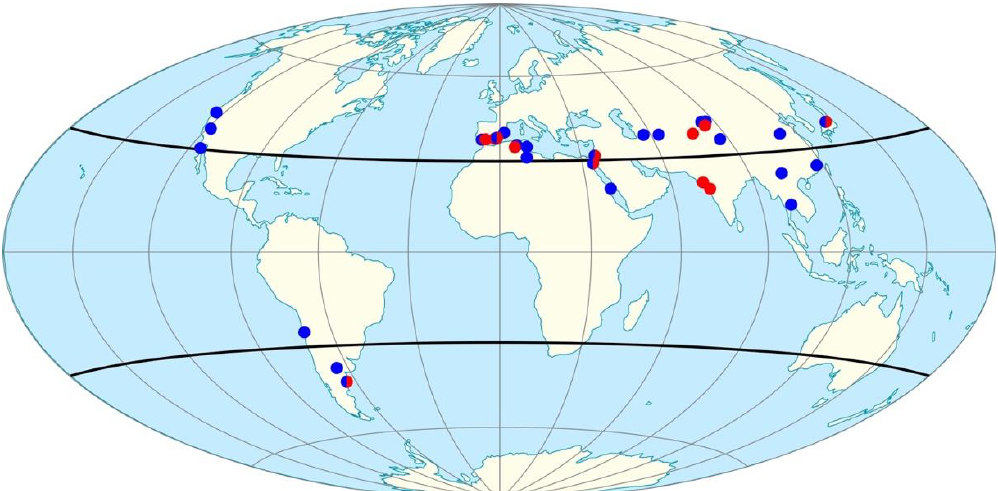
Figure 5. Geographic distribution of halophilic archaea species/strains matched by16S rRNA homology to Great Salt Lake isolates. Red circles indicate matches from cultivars isolated from feathers (Table 1) and blue circles indicate those from shore halite (Table 2). The darkened lines indicate the boundaries of the Subtropical jet streams (North and South). Image credit: Great Salt Lake Institute at Westminster College using map projection available from Creative Commons.